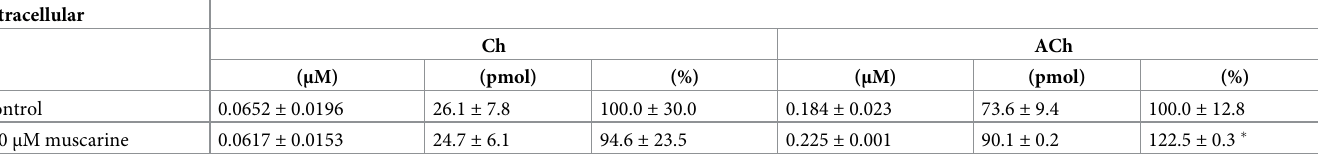
Table 4. Changes in the choline and acetylcholine levels in LA-N-2 cells after treatment with muscarine, a muscarinic acetylcholine receptor agonist. Intracellular